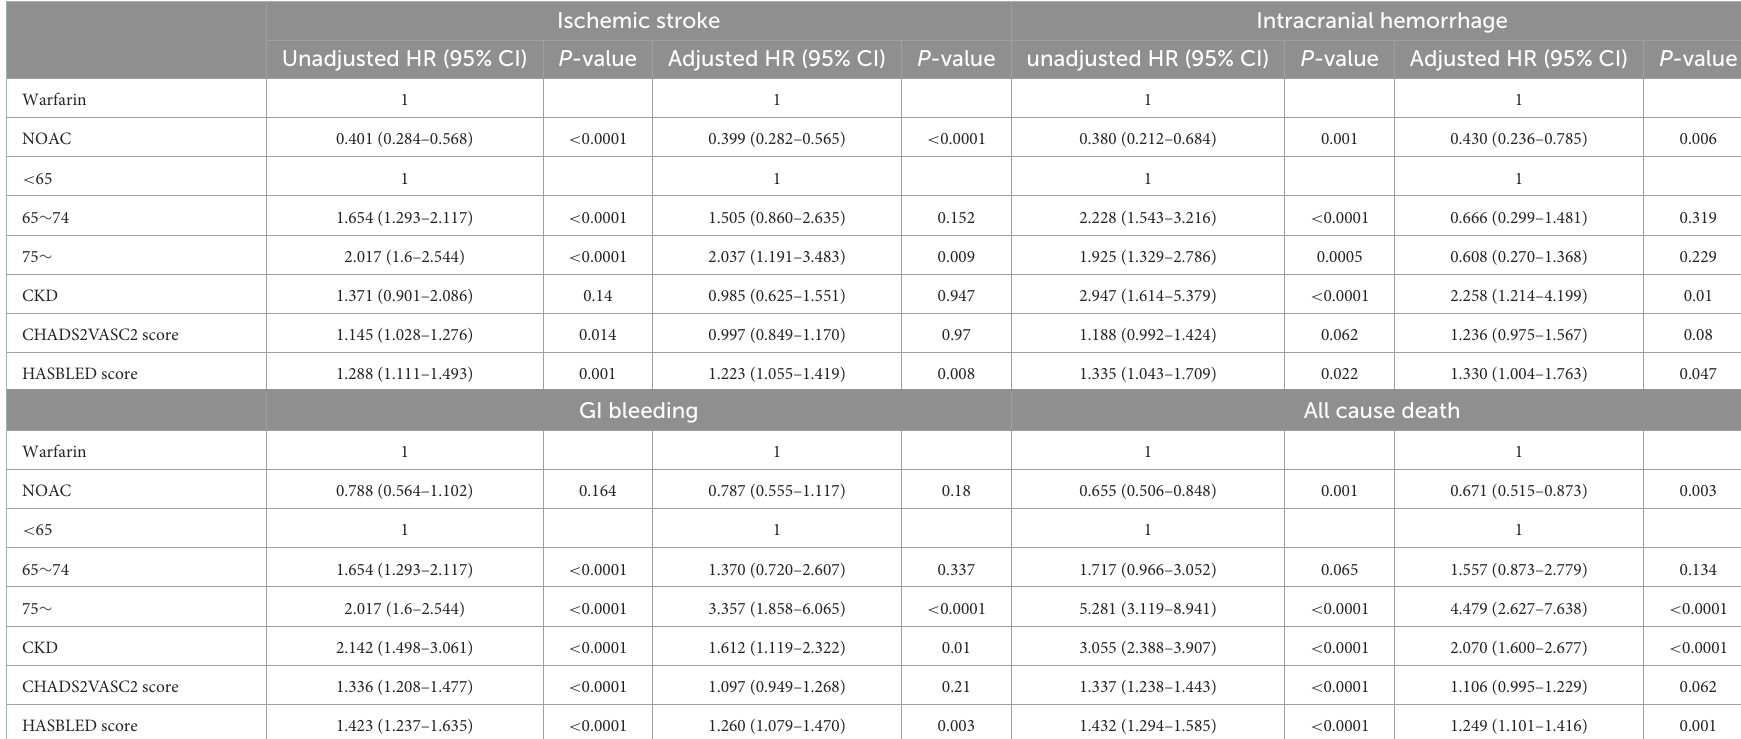
TABLE 3 Hazards for ischemic stroke intracranial hemorrhage, GI bleeding and cardiovascular death (CDW-O